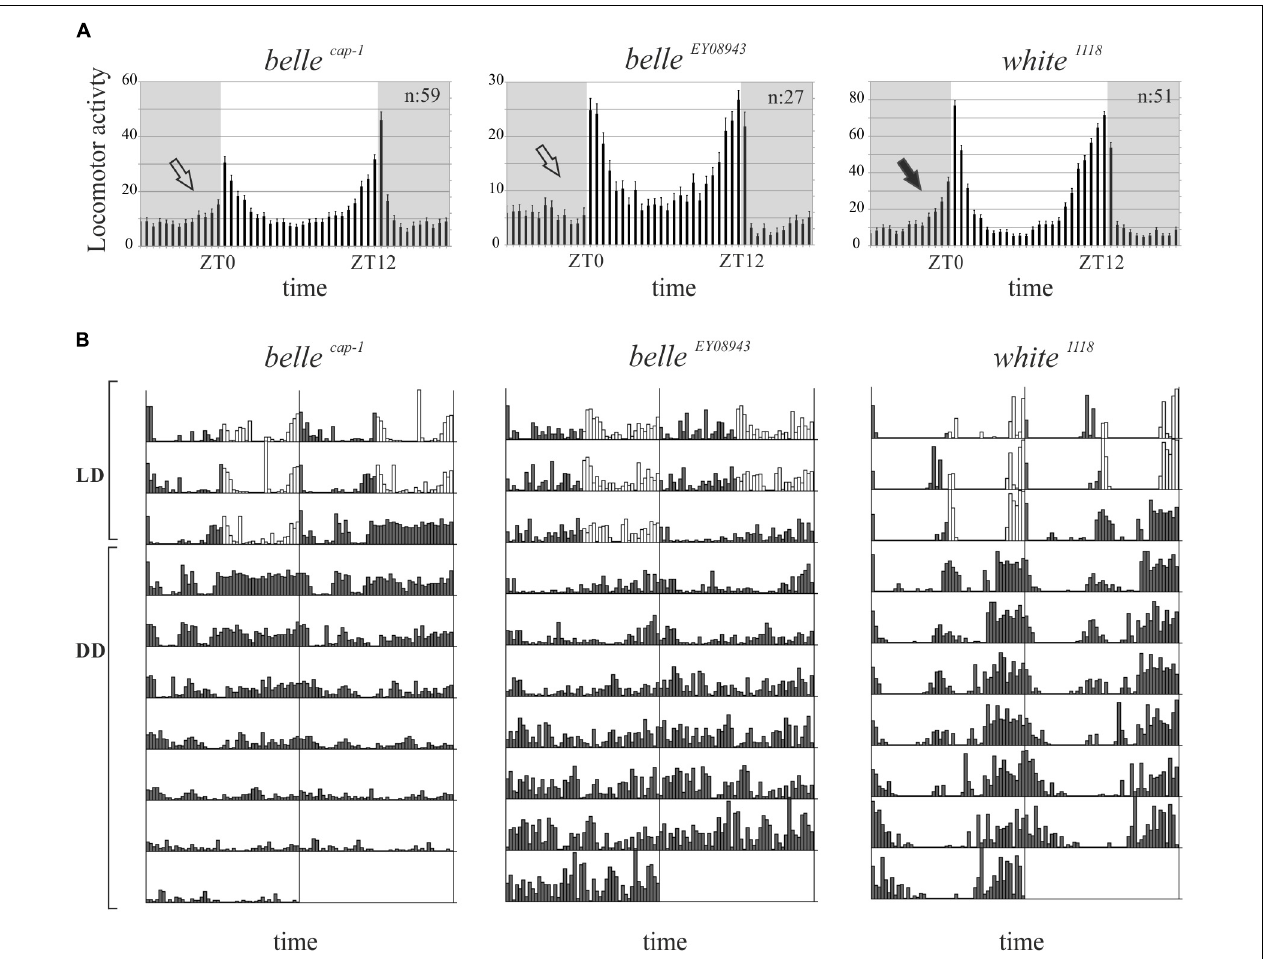
FIGURE 5 | BELLE affects circadian locomotor activity. (A) Activity means of flies over 3 days of LD cycles ± SEM. N: number of flies; gray boxes: dark phase. Belle mutants lost the morning anticipation (empty arrows) compared to control (black arrow). ZT0: lights-on, ZT12: lights-off. (B) Representative double-plotted locomotor activity of a single fly recorded for 3 days under LD and 7 days under DD conditions (gray bars: dark phase; white bars: light phase). LD: light–dark cycles; DD: constant darkness.